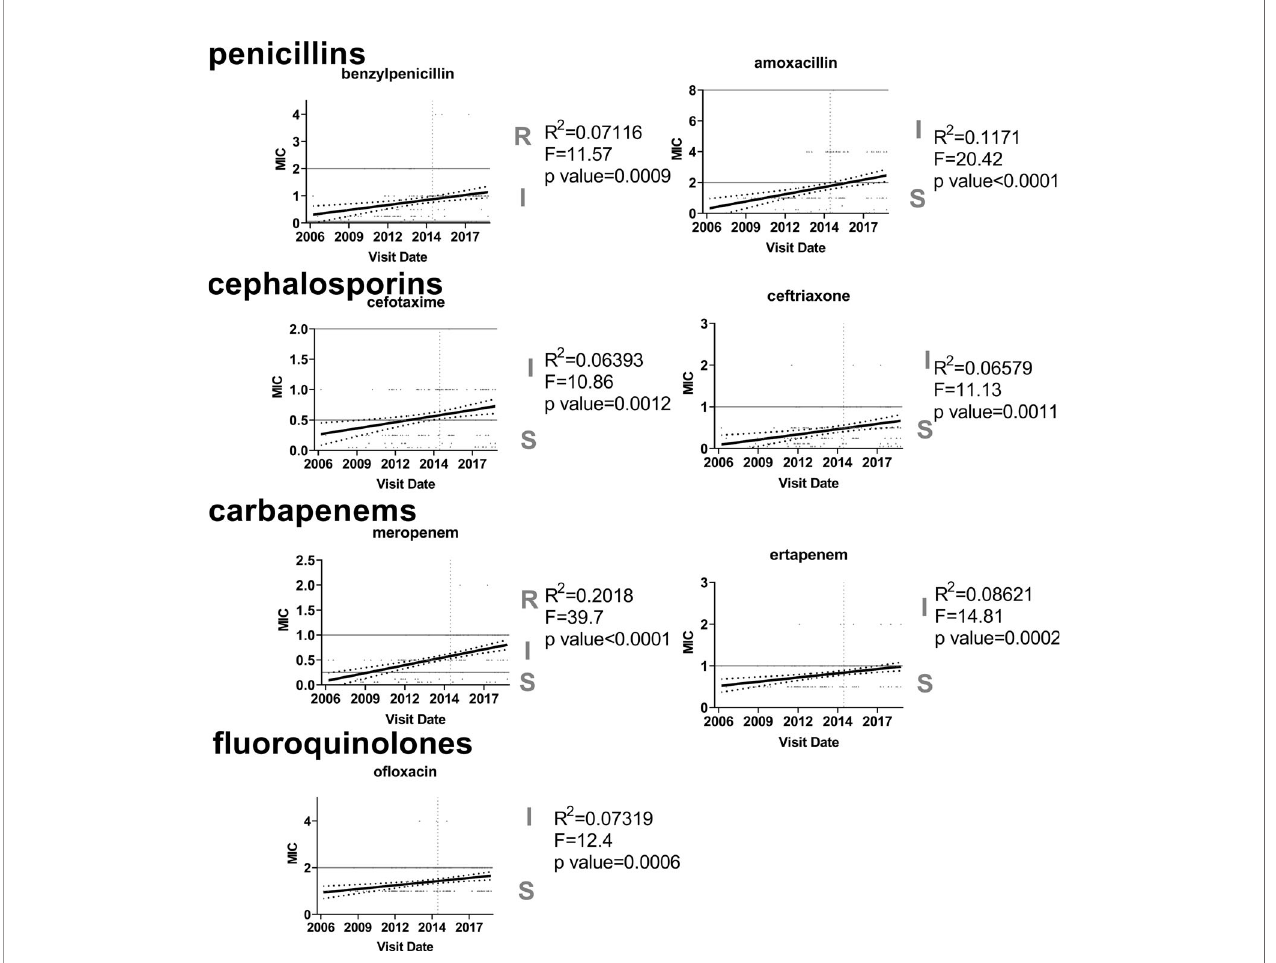
FIGURE 5 | Increasing trend in antibiotic resistance among 35B serotype. Linear regression was used to analyze MIC values (µg/ml) for each antibiotic (n=170). Only seven antibiotics that showed signi fi cant increasing trends are